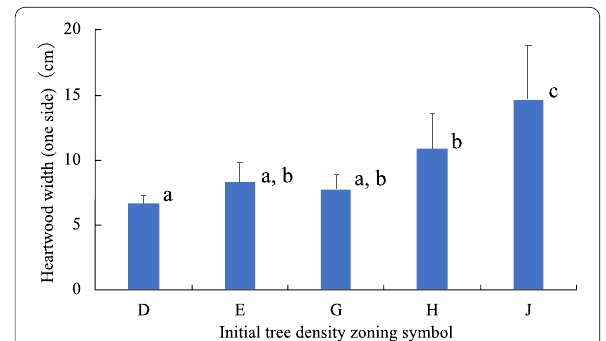
Fig. 10 Effects of initial tree density on heartwood width. Each bar and error bars show a mean and a standard deviation of eight or nine trees of each tree density zoning symbol. Different characters